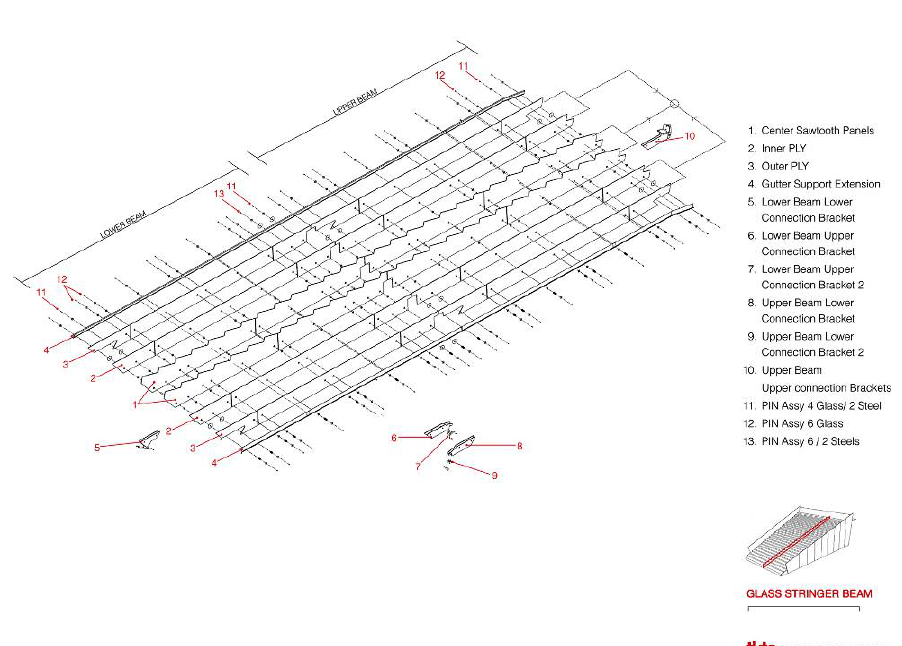
Figure 4: Exploded view of beam showing overlap